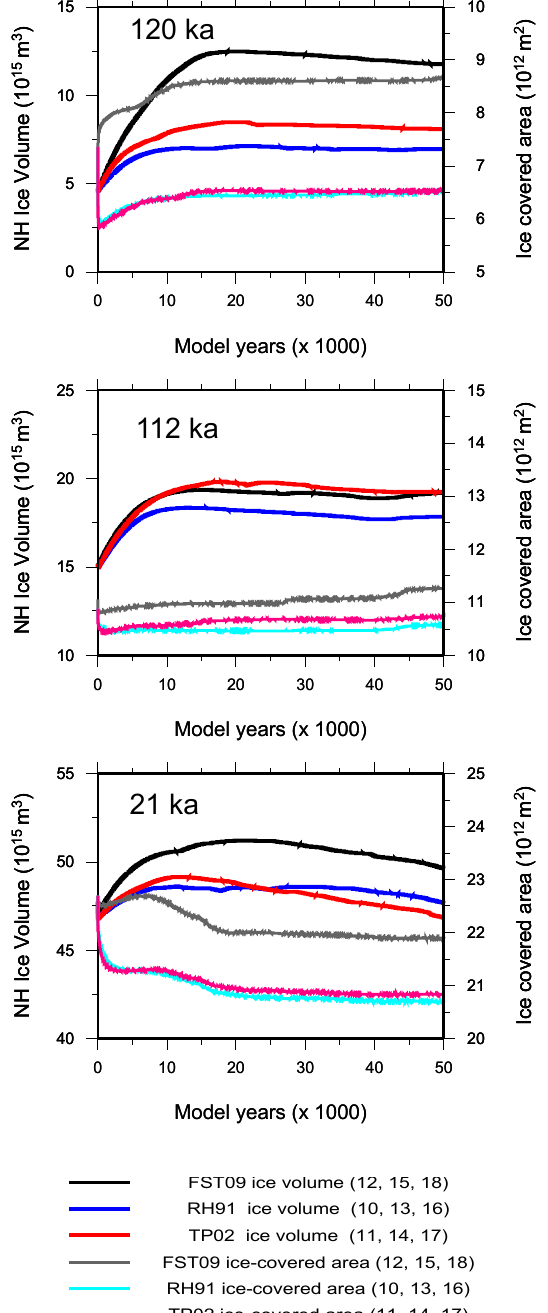
Fig. 3. Evolution of the simulated ice volumes (thick solid lines) and ice-covered areas (thin solid lines) in the GRISLI equilibrium experiments run with the three PDD models. In these experiments, GRISLI is forced by CLIMBER snapshots for 120, 112 and 21ka (see Table 2b and text for a comprehensive description of the exper- iments). Numbers in parenthesis refer to the run identifiers (runs 10 to